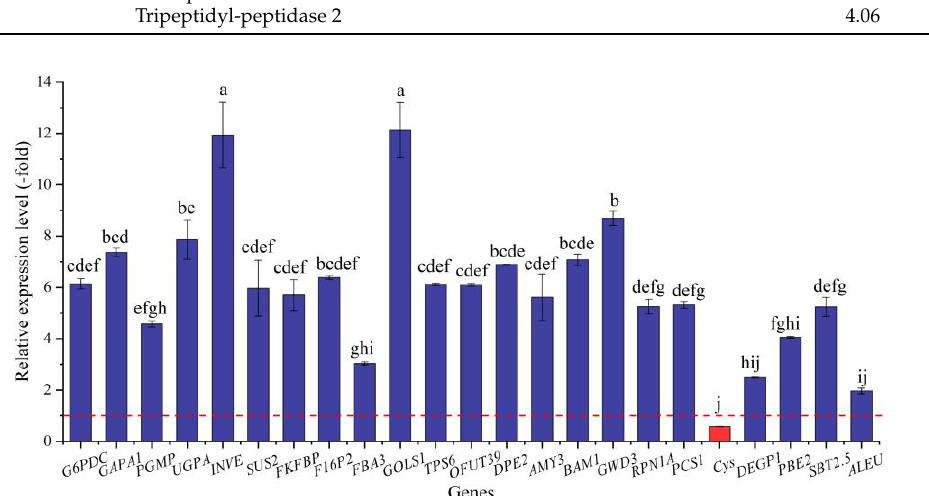
3.61 Figure 9. The RELs of genes directly associated with cell morphogenesis for seed germination in A. venetum seeds at 300 mmol/L NaCl vs. CK (mean ± SD, n = 3). Different letters represent a significant difference ( p < 0.05) among different genes. The red dotted line differentiates UR (>1) and DR (<1).